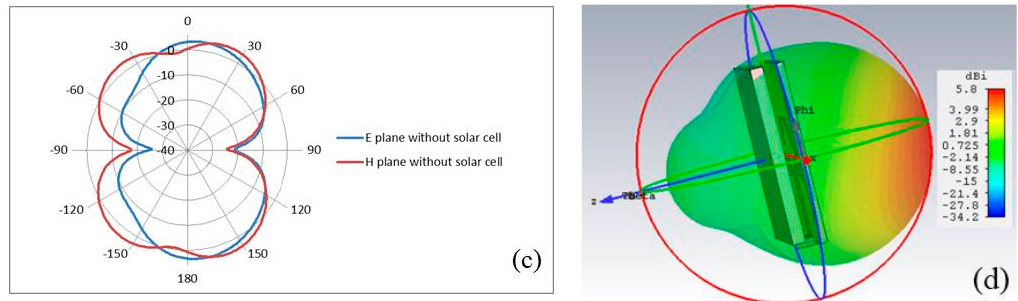
Figure 6. ( a ) Simulated radiation patterns of the proposed antenna with and without OSC downlink for E-plane, ( b ) for H-plane, ( c ) measured radiation patterns of the antenna structure downlink for E-plane and H-plane, and ( d ) simulated 3D radiation pattern for the proposed antenna.